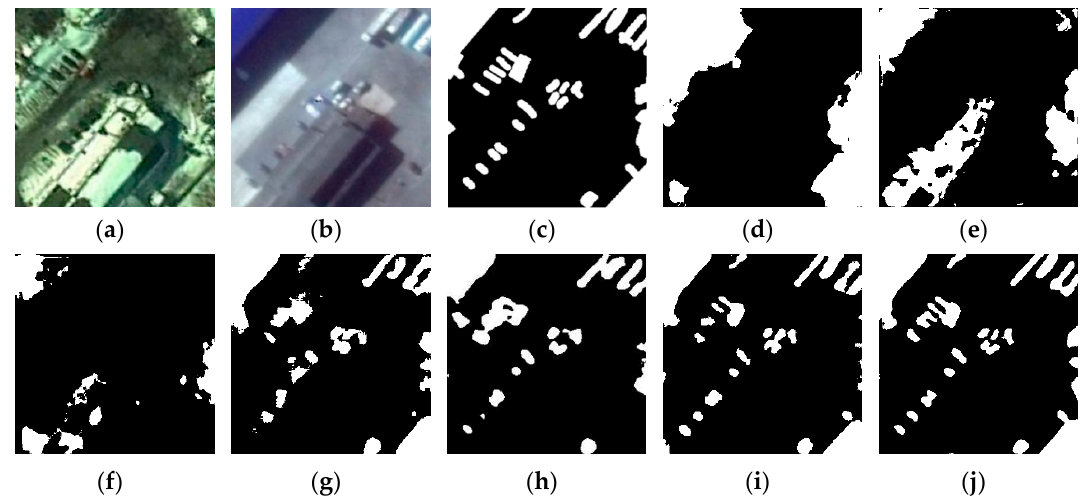
Figure 8. Visual comparison of change detection results in area 3: ( a ) T1 image, ( b ) T2 image, ( c ) ground truth, ( d ) FC-EF, ( e ) FC-Siam-conc, ( f ) FC-Siam-diff, ( g ) UNet++_MSOF, ( h ) IFN, ( i ) SNUNet-CD/32, ( j ) proposed method. The changed areas are marked by white, and the unchanged areas are marked by black.